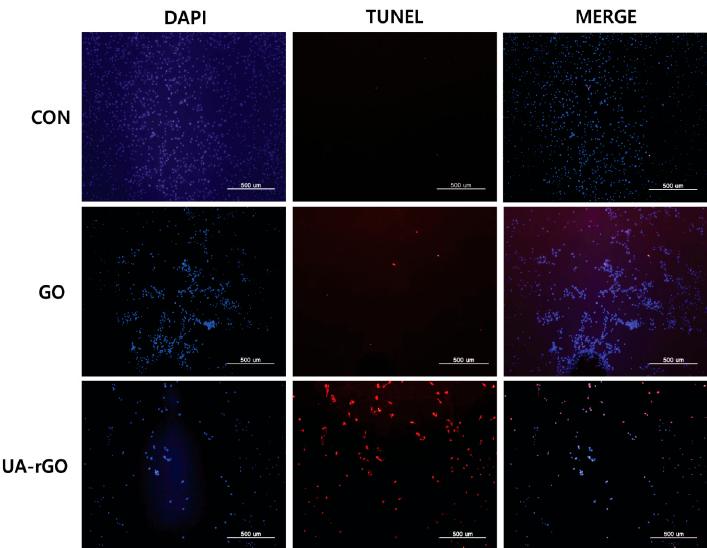
Figure 12. GO and UA-rGO induce apoptosis in human ovarian cancer cells. Apoptosis of human ovarian cancer cells after 24 h treatment with 20 μ g/mL of GO and UA-rGO was assessed by the TUNEL assay; the nuclei were counterstained with DAPI. Representative images show apoptotic (fragmented) DNA (red) and corresponding nuclei (blue).